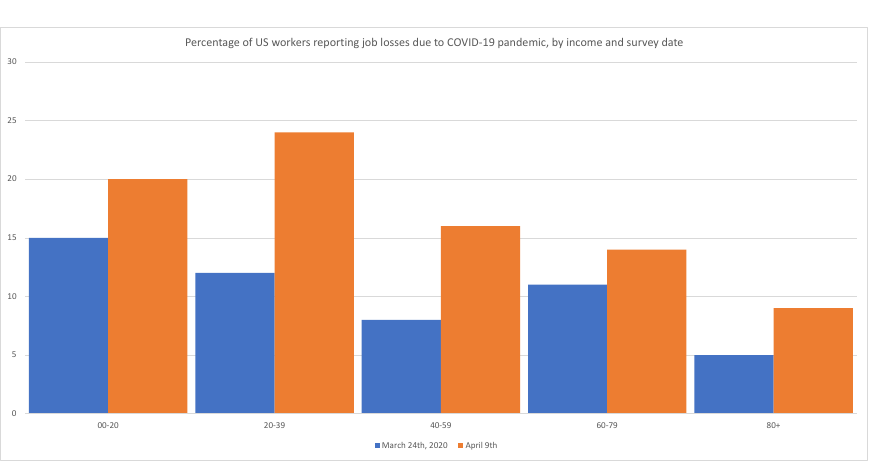
Figure 4. Government interventions have a disproportionate adverse effect on minorities, the working class, and the poor. Source: Adams-Prassl et al.